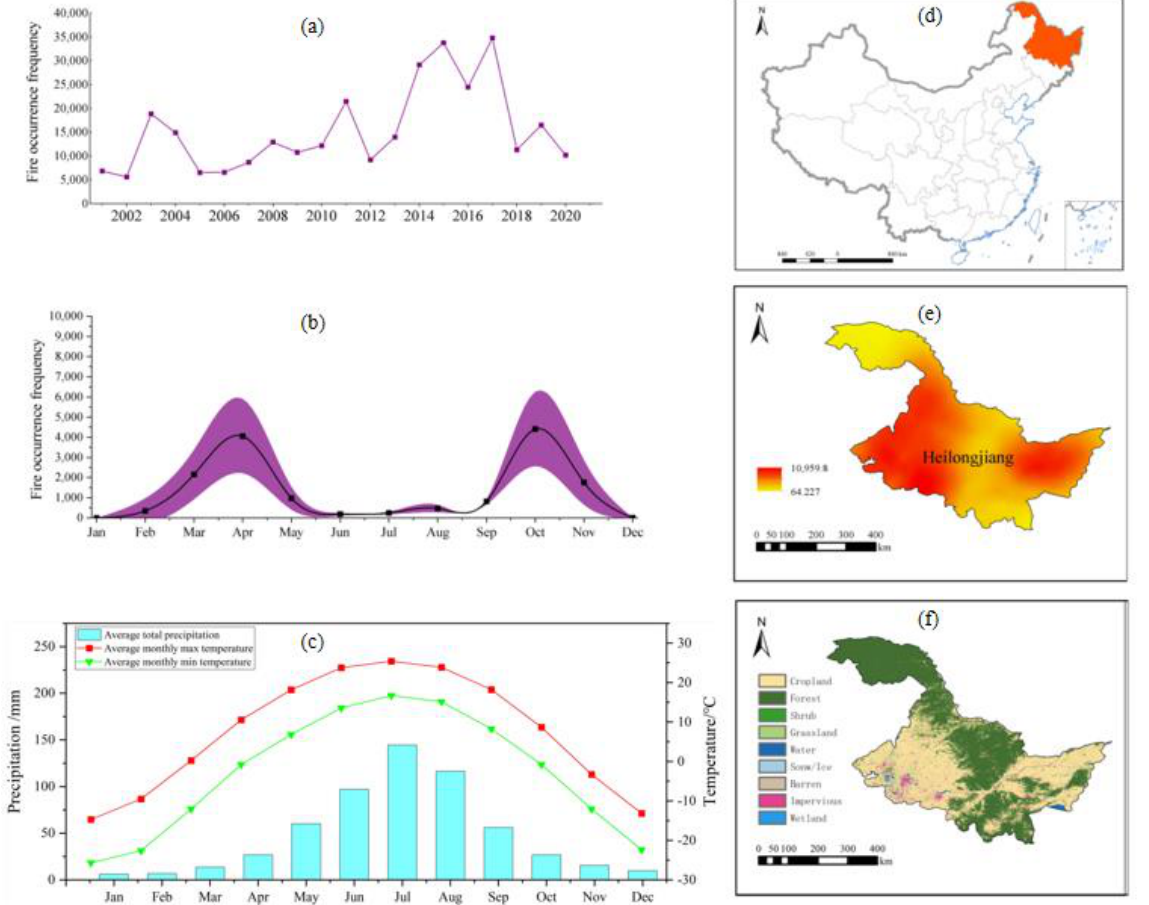
Figure 5. The total ( a ) occurrence frequencies of active fires over the study period, ( b ) monthly average number of active fire occurrence frequencies and their 95% confidence intervals (purple area), ( c ) average rainfall and temperature, ( d ) geographical position of Heilongjiang in China, ( e ) spatial difference in hotspot density of active fires during 2001 – 2020, and ( f ) spatial difference in land cover in Heilongjiang in 2020.